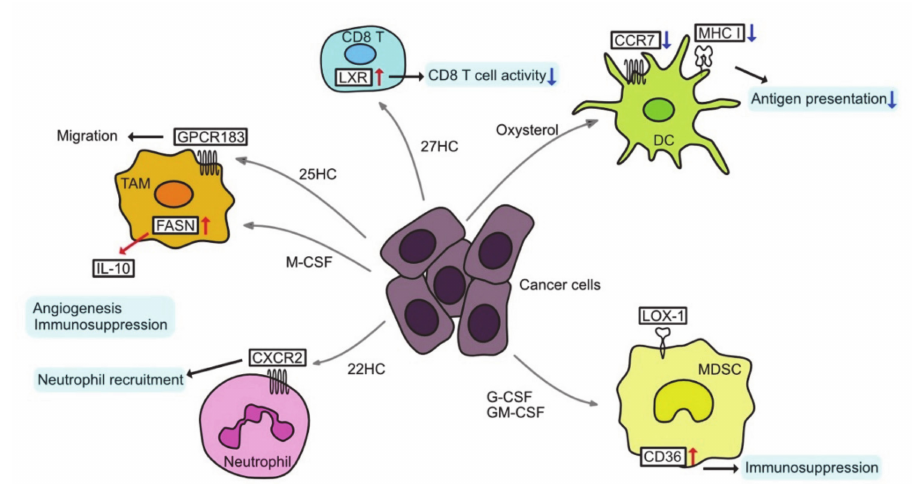
Figure 3. Altered lipid metabolism and tumor microenvironment. CCR7, C-C chemokine receptor type 7; CXCR2, C-X-C chemokine receptor type 2; DC, dendritic cell; G-CSF, granulocyte colony-stimulating factor; GM-CSF, granulo- cyte macrophage colony-stimulating factor; GPCR 183, G-protein-coupled receptor 183; HC, hydroxycholesterol; IL-10, interleukin-10; LOX-1, lectin-like oxidized low-density lipoprotein (LDL) receptor-1; M − CSF, macrophage colony stimulat- ing factor; MDSC, myeloid-derived suppressor cell; MHC I, major histocompatibility complex class I; TAM, tumor-associated